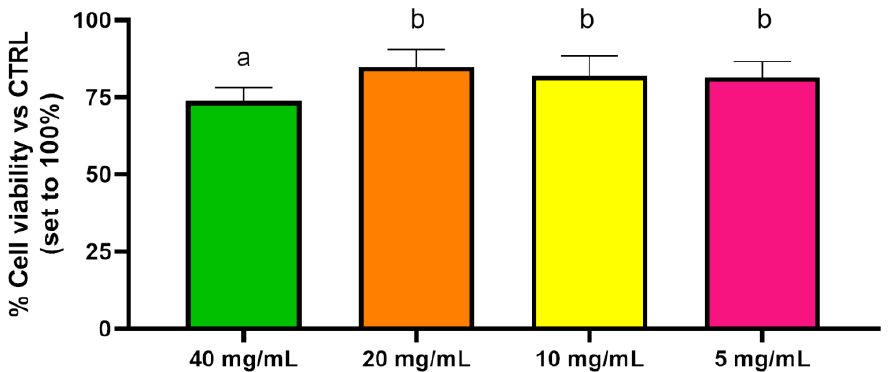
Figure 13. Cell viability evaluation of Balb/3T3 clone A31 cultured with several concentrations of PEGMA- ran -FA for 24 h. Not-shared letters indicate statistically significant differences, p < 0.05.